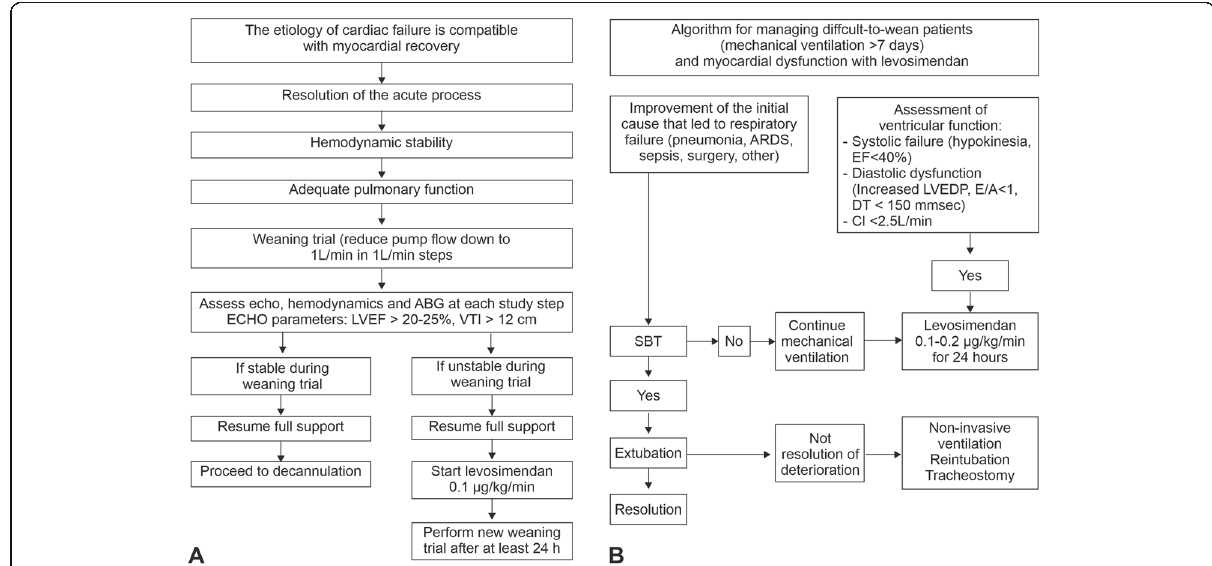
Fig. 3 Algorithms for weaning from a extracorporeal membrane oxygenation and b mechanical ventilation which include levosimendan. Figure drawn freely from Sangalli et al. [55] E/A, ratio of early to late (atrial) peak blood flow during diastole; DT, deceleration time; LVEDP, left ventricular end-diastolic